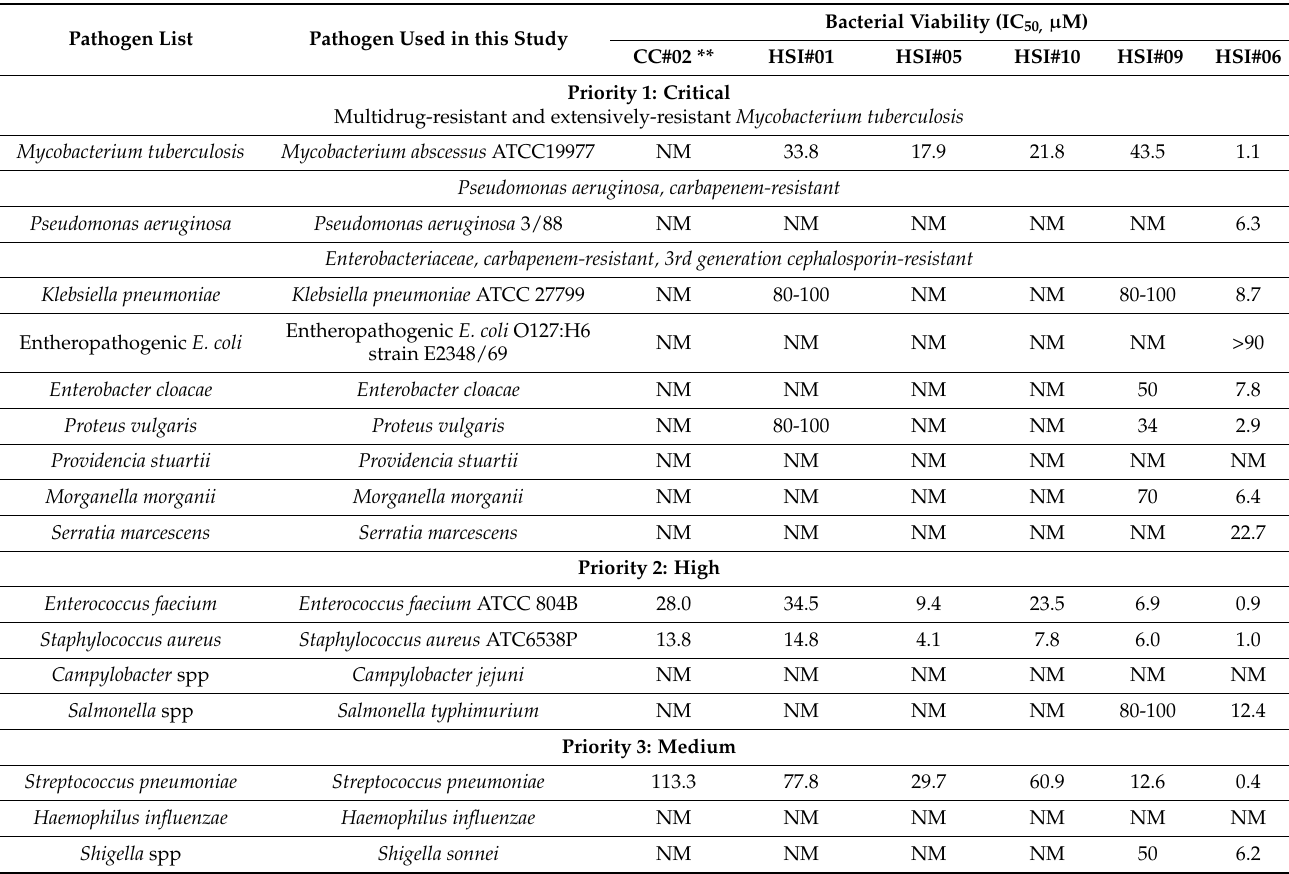
Table 2. Priority pathogens list for R&D of new antibiotics. Adjusted from the WHO 2018 recommendation list [41].